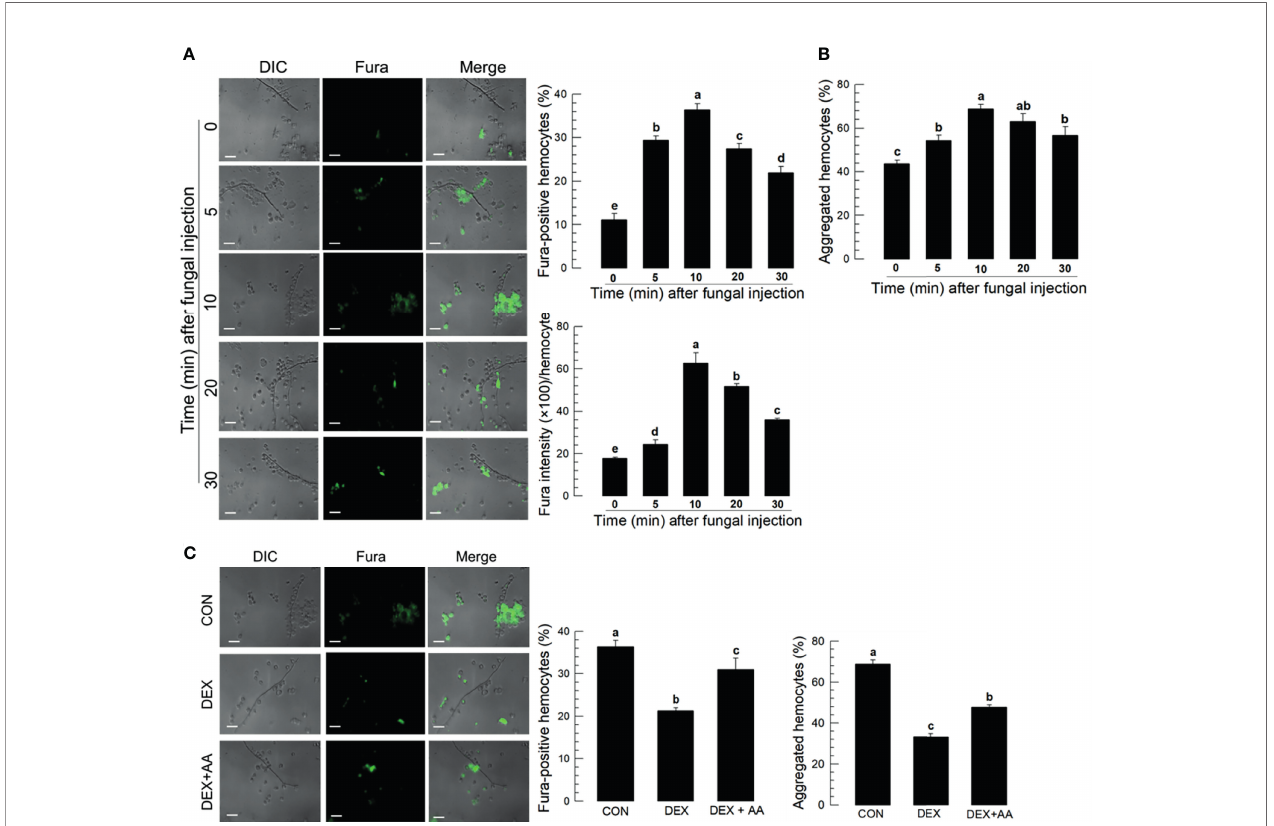
FIGURE 2 | Ca 2+ signal in aggregating hemocytes to fungal hyphae of M. rileyi in S. exigua . Panel (A) conveys the induction of Ca 2+ signals in S. exigua hemocytes. Larvae were injected with 1,000 conidia/L5 larva at 30 min after injecting 2 µL Fura, 1 mM). At the indicated time points, hemolymph was collected and fi xed with 2.5% paraformaldehyde. Fluorescent hemocytes were counted and changes in fl uorescence intensity were recorded as described in Methods . Panel (B) shows proportions of Fura-positive hemocytes (upper left), proportions of aggregated hemocytes (upper right), and Fura intensities/100 hemoytes at the indication times PFI. Panel (C) presents the in fl uence of DEX (10 m g/larva) on hemocyte Ca 2+ signals and hemocyte aggregating behavior after fungal infection. The left panel presents visual images hemocytes after the indicated treatments. The middle histogram reports proportions of Fura-positive hemocytes in controls, hemocytes after DEX exposure, and hemocytes after DEX+AA (10 m g/larva). Each treatment was replicated three times. Data analyzed and presented as described in Methods. Scale bar represents 10 m m. ‘ DIC ’ represents differential interference contrast. ‘ CON ’ represents solvent (DMSO) control. Different letters above standard deviation bars indicate signi fi cant difference among means at Type I error = 0.05 (LSD